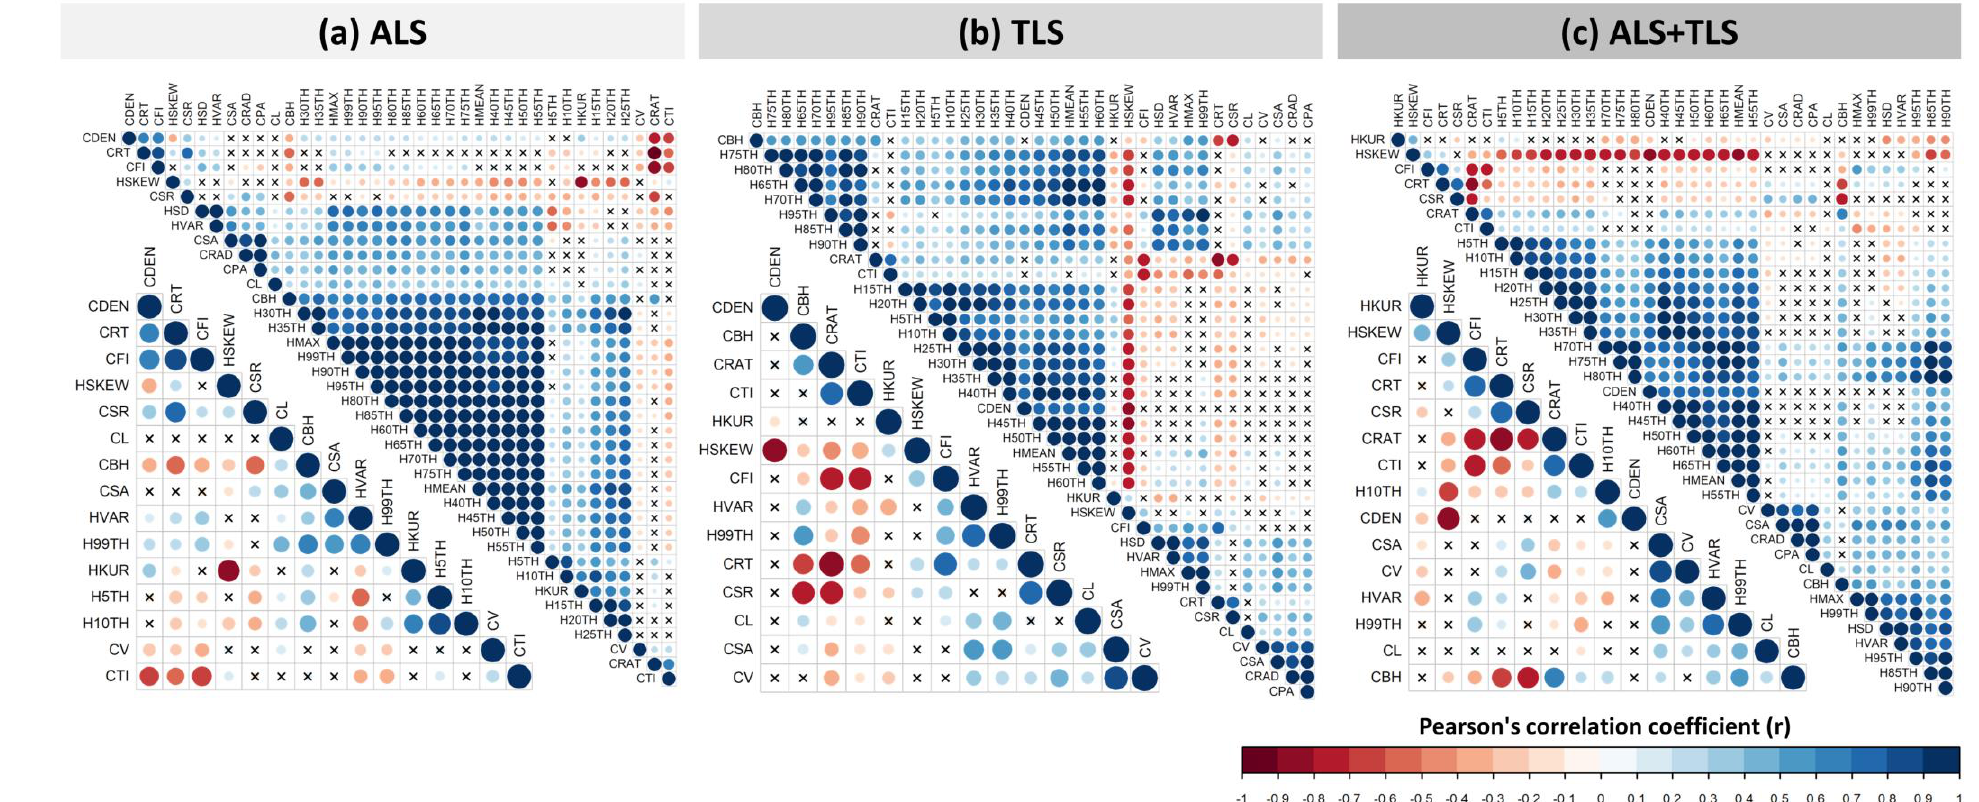
Figure 5. Pearson’s correlation (r) among all the ALS ( a ), TLS ( b ), and ALS + TLS ( c ) derived crown-level metrics (upper triangle) and not highly correlated ( − 0.9 < r < 0.9) metrics (lower triangle). The “x” resents relationships where the r value is statistically equal to zero ( p -value > 0.05).